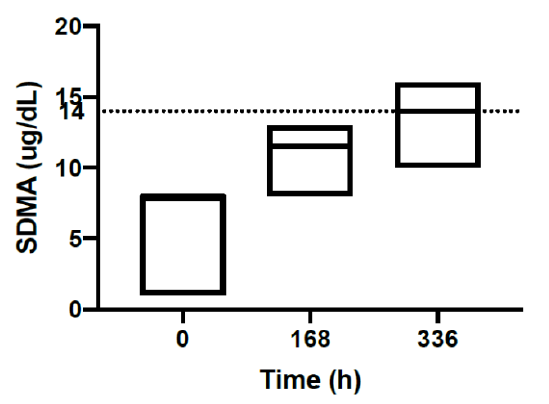
Figure 3. SDMA results (ug / dL) of six cats at 0, 168 and 336 h. The median SDMA concentration of each time point is shown with the upper and lower range. The dotted line represents the reference interval (0.00–14.0).